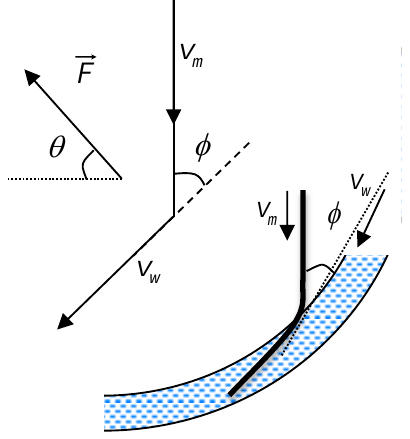
Figure 7. Velocity change and force exerted at the confluence of melt and water